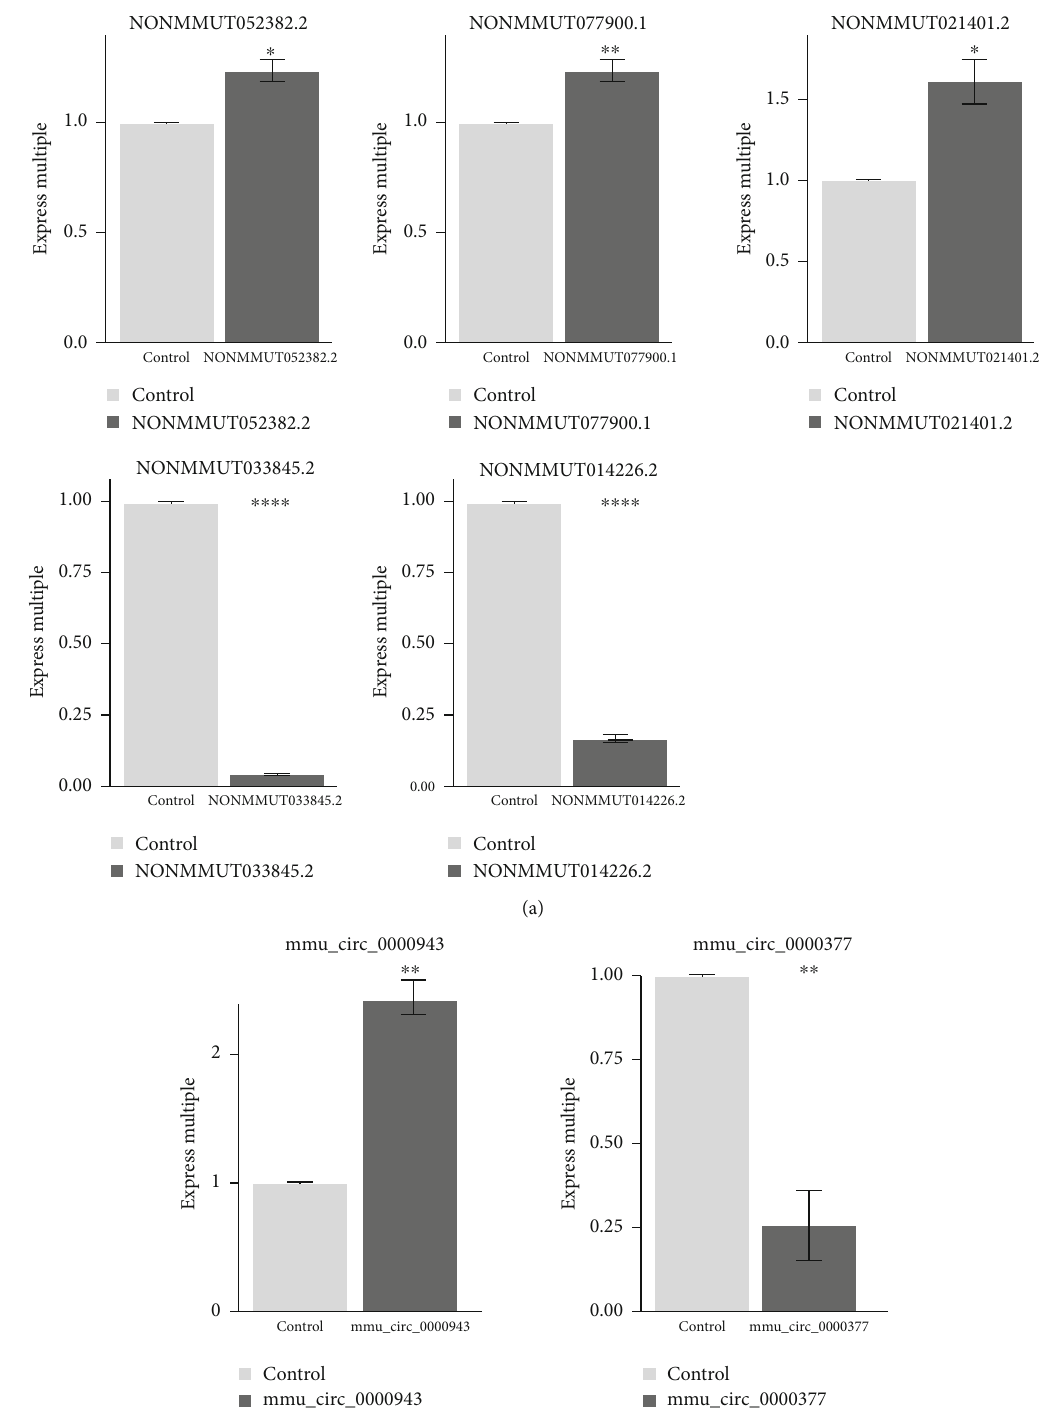
Figure 10: qRT-PCR validation results of selected lncRNAs and circRNAs. (a) Expression levels of the 5 selected lncRNAs veri fi ed by qPCR. (b) The expression levels of the 2 selected circRNAs veri fi ed by